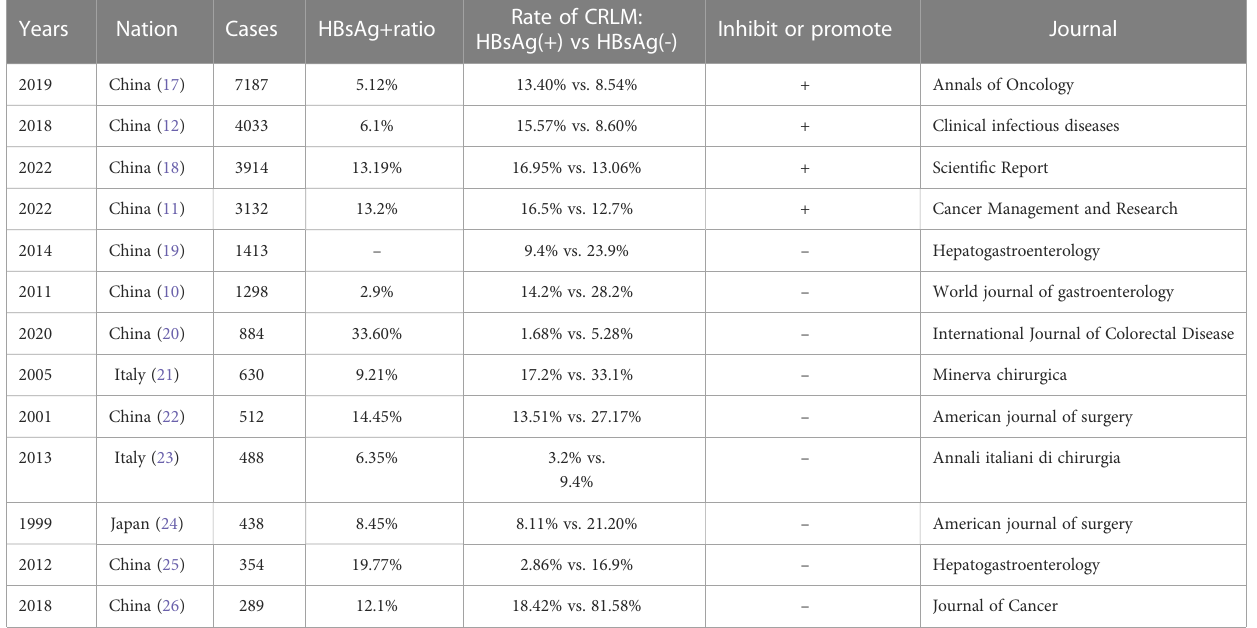
TABLE 2 Effects of HBV on CRC liver metastases published during